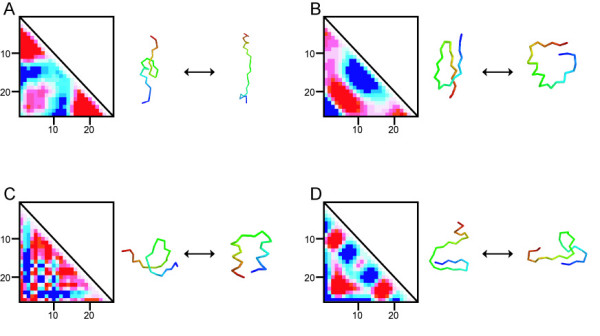
Examples of class-specific conformational axes. Conformational axes specific to structural class for 26-residue segments are shown. Eigenvector maps and conformations picked up from both ends on each PC axis are shown: A for PCα8, B for PCα/β8, C for PCα10, and D for PCβ10. The color contrast of the maps is enhanced to aid viewing. The anti-phase of the blue color is shown in red. Residue numbers are displayed with horizontal and vertical sides of each triangle map. The respective contribution ratios of PCα 8, PCα/β8, PCα10, and PCβ10 were 1.3%, 1.4%, 0.9%, and 0.7%.